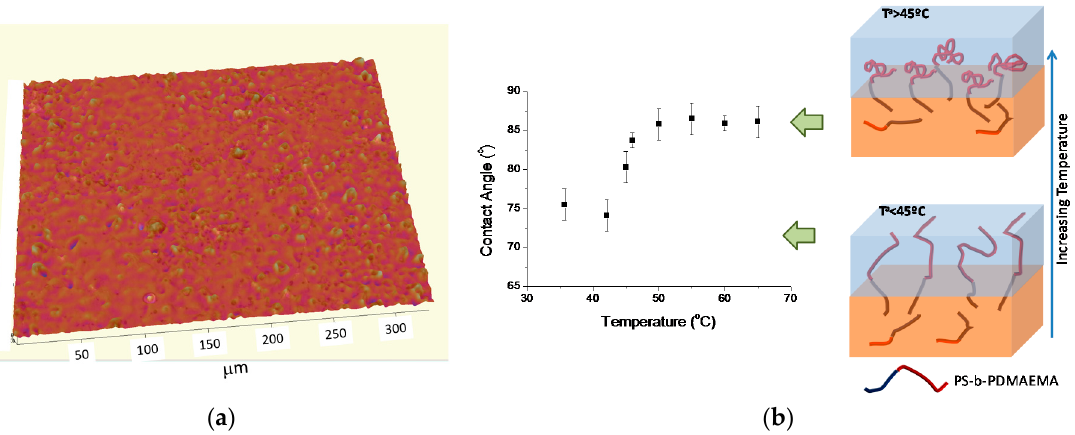
Figure 7. ( a ) Surface image obtained by using a 3D-optical profiler; ( b ) Variation of the contact angle as a function of the temperature on sprayed films composed of 50 wt % of PS and 50 wt % of PS- b -PDMAEMA. The polymer concentration employed was 50 mg/mL.